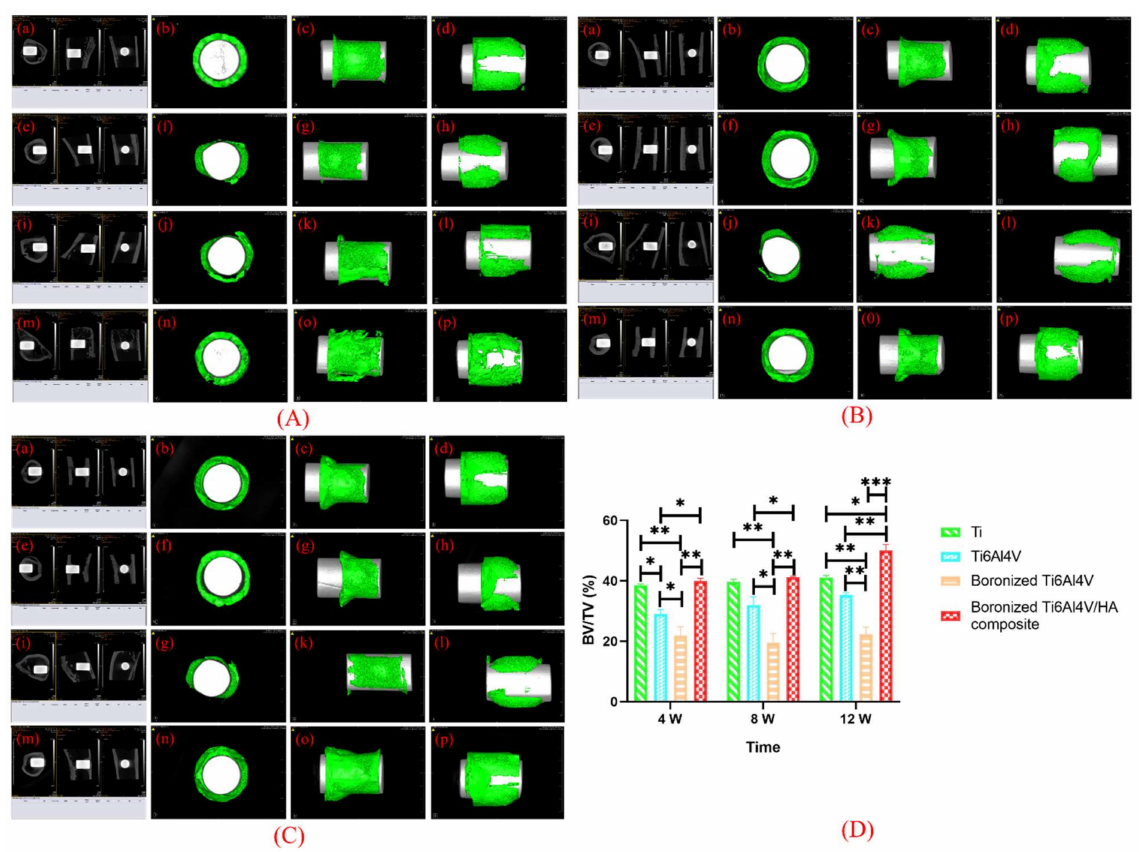
Figure 6. Characterization of implants and the surrounding bones by micro-CT scanning at the ( A ) 4th, ( B ) 8th, and ( C ) 12th weeks after implantation: ( a – d ) Ti, ( e – h ) Ti6Al4V, ( i – l ) boronized Ti6Al4V, and ( m – p ) boronized Ti6Al4V/HA composite. ( D ) Quantitative analysis of BV/TV by micro-CT (* p < 0.05, ** p < 0.01, and *** p <